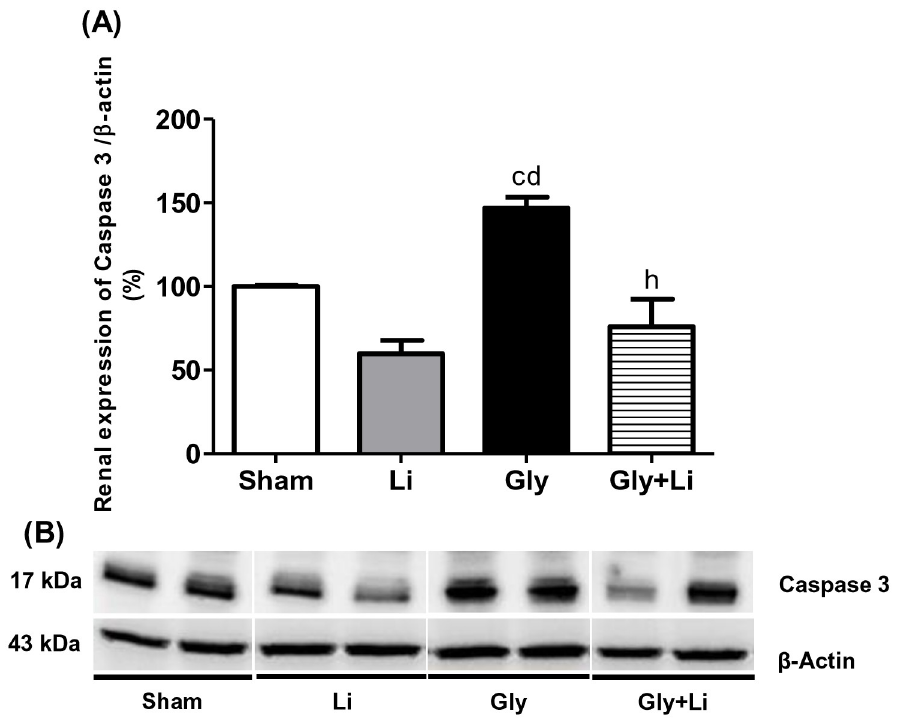
Fig 5. Semiquantitative immunoblotting for Caspase 3 expression in rat kidney tissue. (A) Caspase 3 densitometric analysis of kidney samples from Sham, Li, Gly and Gly+Li rats. (B) Representative immunoblots which reacted with anti-Caspase 3 revealing bands of 17kDa. Values are means ± SEM. c p < 0.05 vs. Sham; d p < 0.001 vs. Li, h p < 0.01 vs. Gly. Li, lithium; Gly, glycerol; Gly+Li, glycerol + lithium.